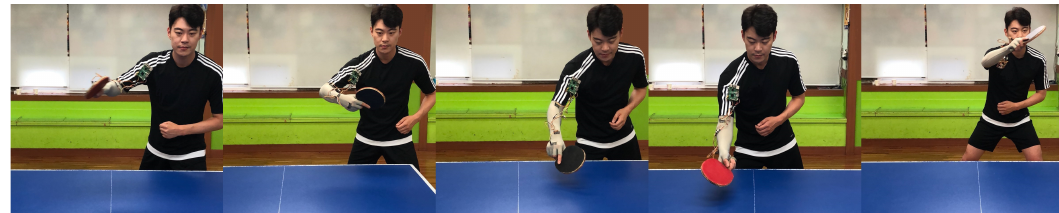
Figure 2. Table tennis motion skills considered in this paper (from left to right): Forehand stroke, backhand drive, backhand short, forehand cut, forehand